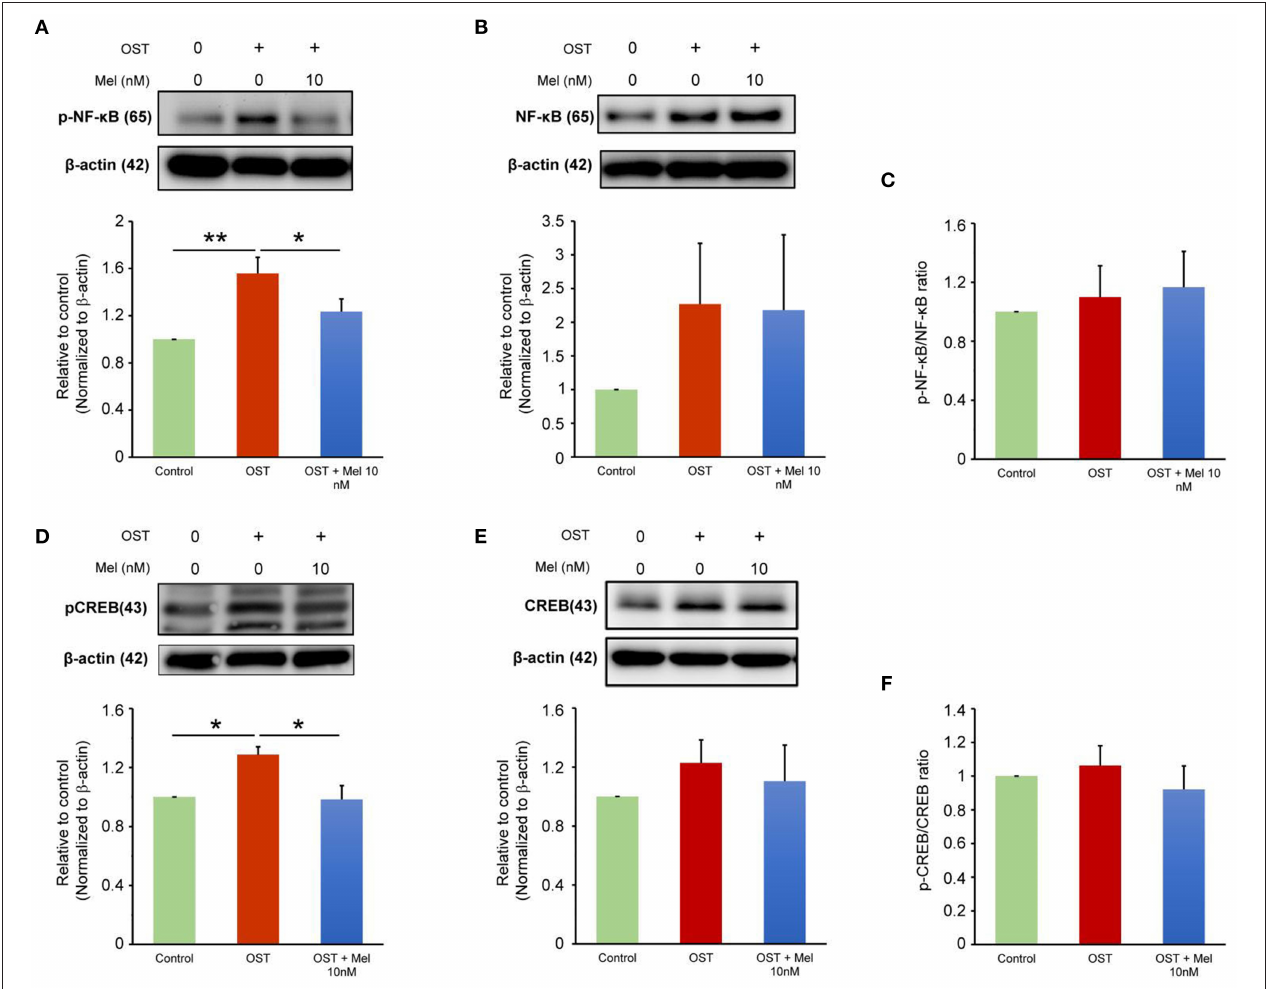
FIGURE 2 | Effect of melatonin on NF- κ B and CREB signaling. (A–C) Representative Western blots and summary data for the effect of melatonin on pNF- κ B and NF- κ B protein expression in OST medium-treated VICs with or without melatonin (10 nmol/L) administration for 5 days ( n = 7). β -actin was used as an internal control. (D–F) Representative Western blots and summary data for the effect of melatonin on the levels of pCREB and CREB in OST medium treated VICs with or without melatonin (10 nmol/L) for 5 days ( n = 6). β -actin was used as an internal control. Data are presented as mean ± SEM. OST, osteogenic medium; Mel, melatonin. * P < 0.05, ** P <